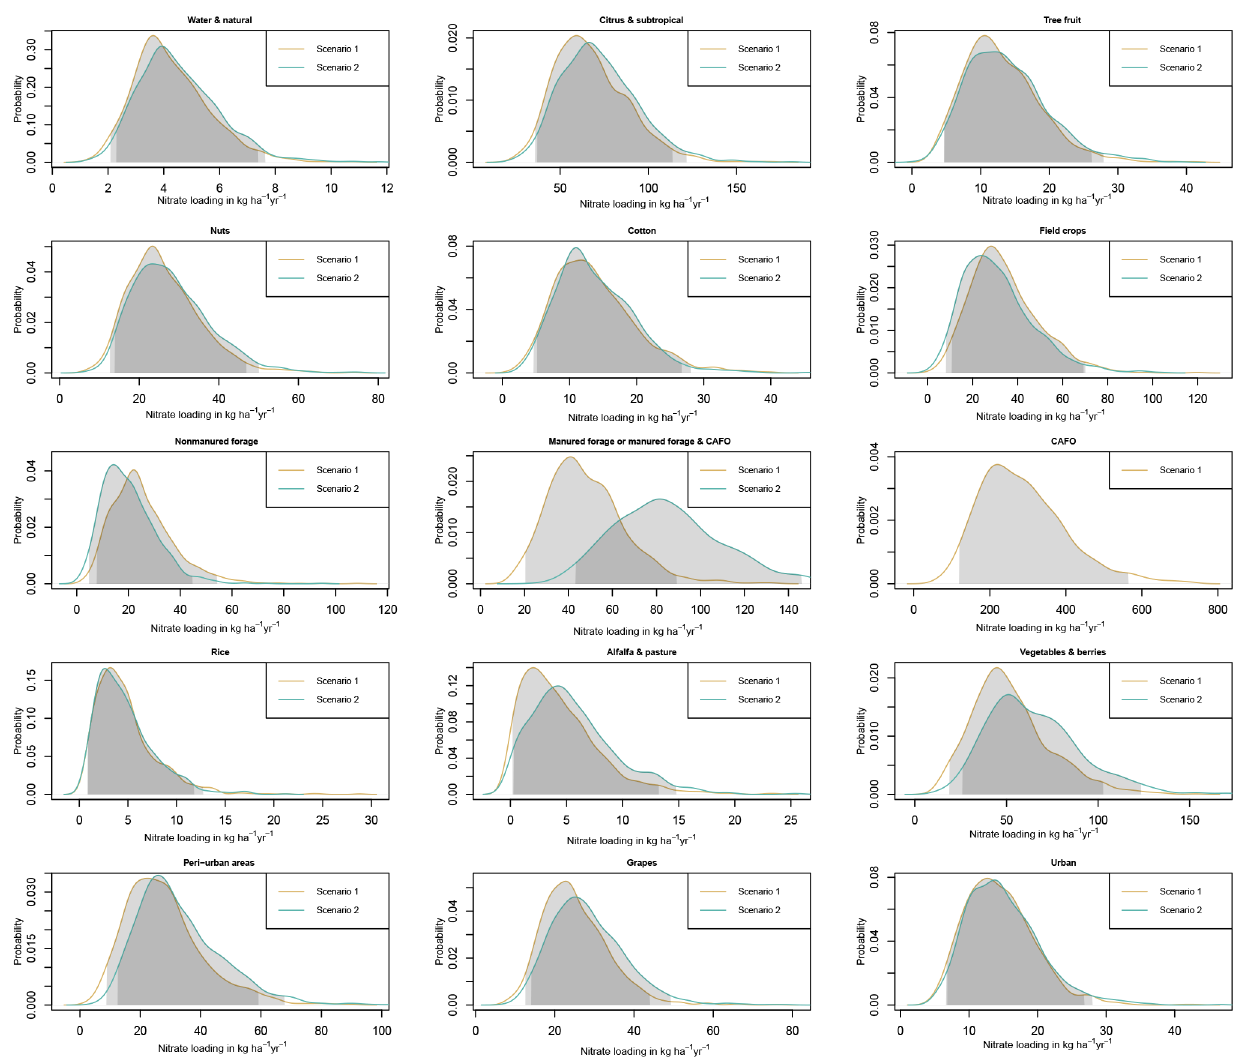
Figure 5. Posterior probability densities of estimated nitrogen loading for scenario 1 (tan) and 2 (teal). Credibility intervals of 95% are represented by the light grey shading (dark grey shading occurs where scenario 1 and 2 estimates